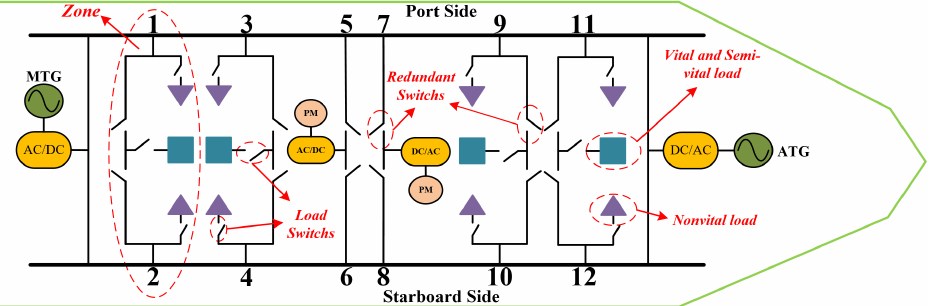
Figure 1. MVDC shipboard power system architecture. Table 1. Main notations and